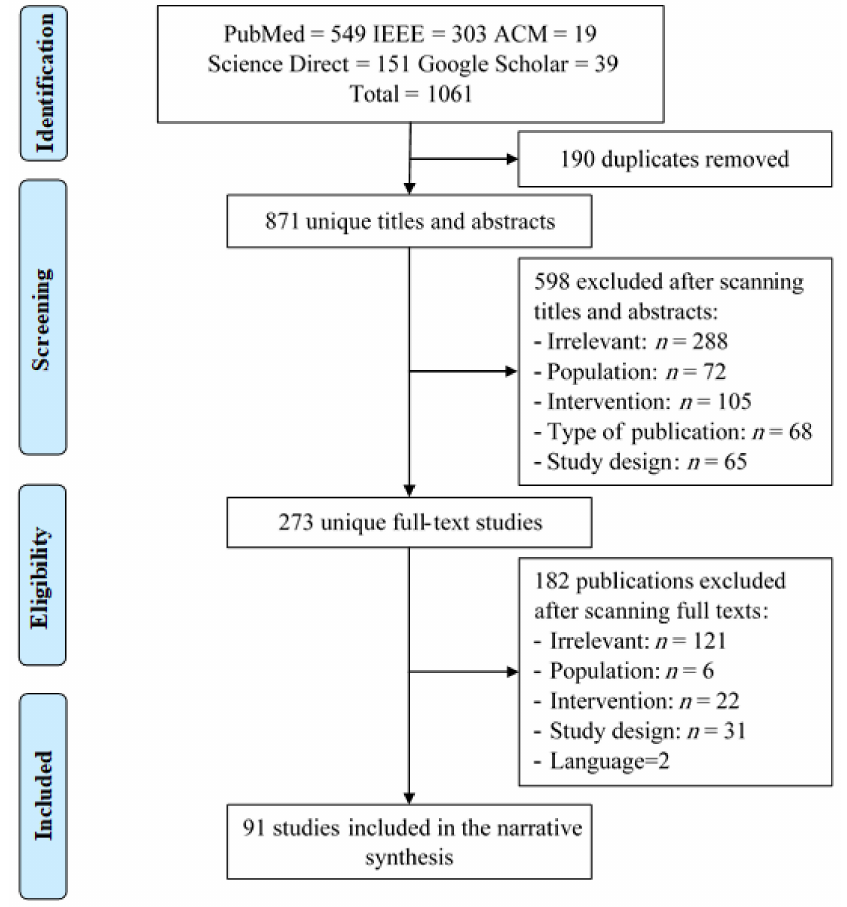
Figure 1. PRISMA